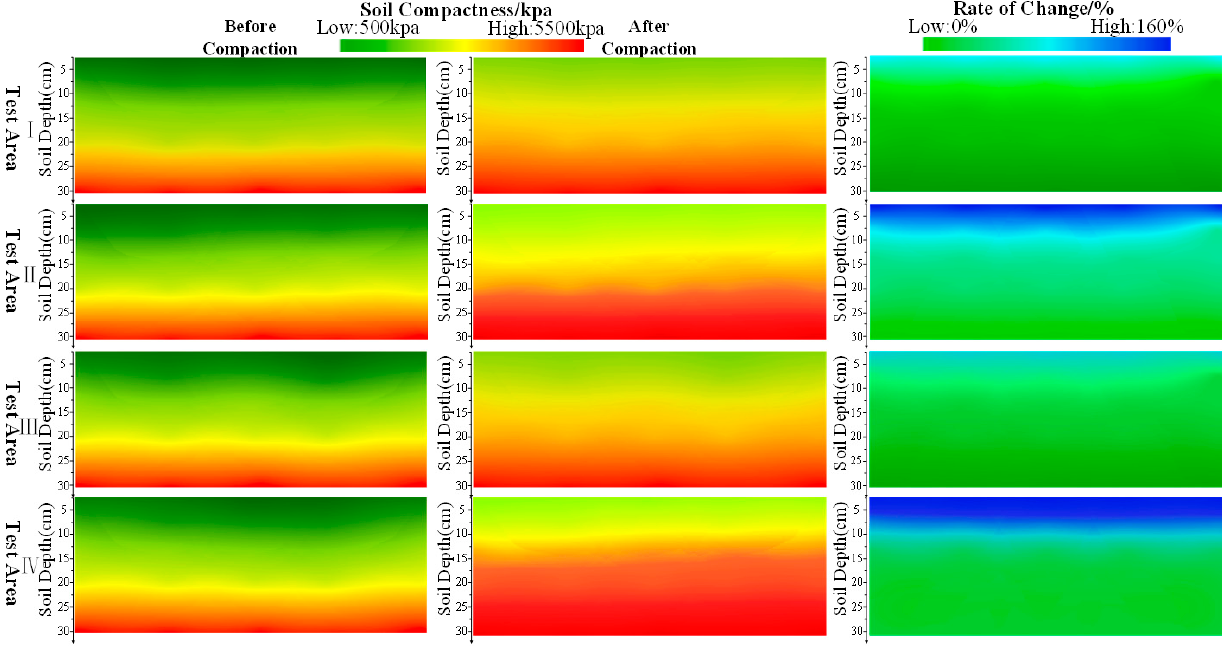
Figure 4. Longitudinal profile clouds of soil compactness before and after compaction in each test area .